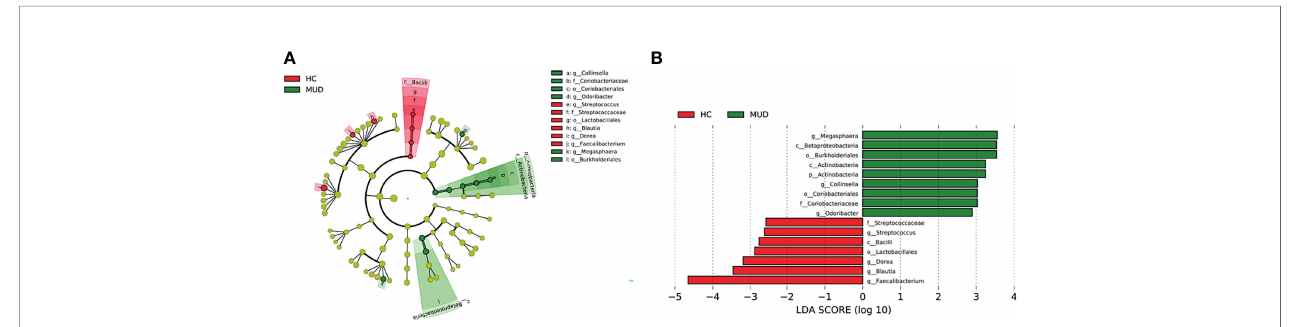
FIGURE 1 | Taxa with signi fi cant different abundance between the MUD and HC groups. (A) Taxonomic cladogram obtained from LEfSe analysis displaying differentially enriched bacterial taxa in HC (red) and MUD (green). (B) Linear discriminant analysis (LDA) revealed the effect size of each differentially abundant taxa (LDA score > 2, p < 0.05).